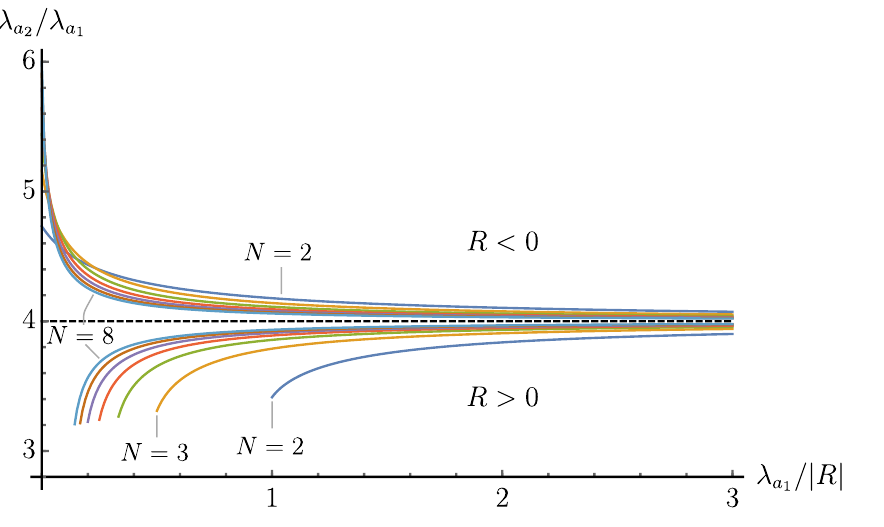
Figure 3 . Upper bounds on the ratio of the (cid:12)rst distinct nonzero eigenvalues of the scalar Laplacian for closed Einstein manifolds with R 6 = 0 and N = 2 ; : : : ; 8, assuming that (cid:21) I (cid:21) 0. The minimum eigenvalues for R > 0 are set by the Lichnerowicz bound (2.6).